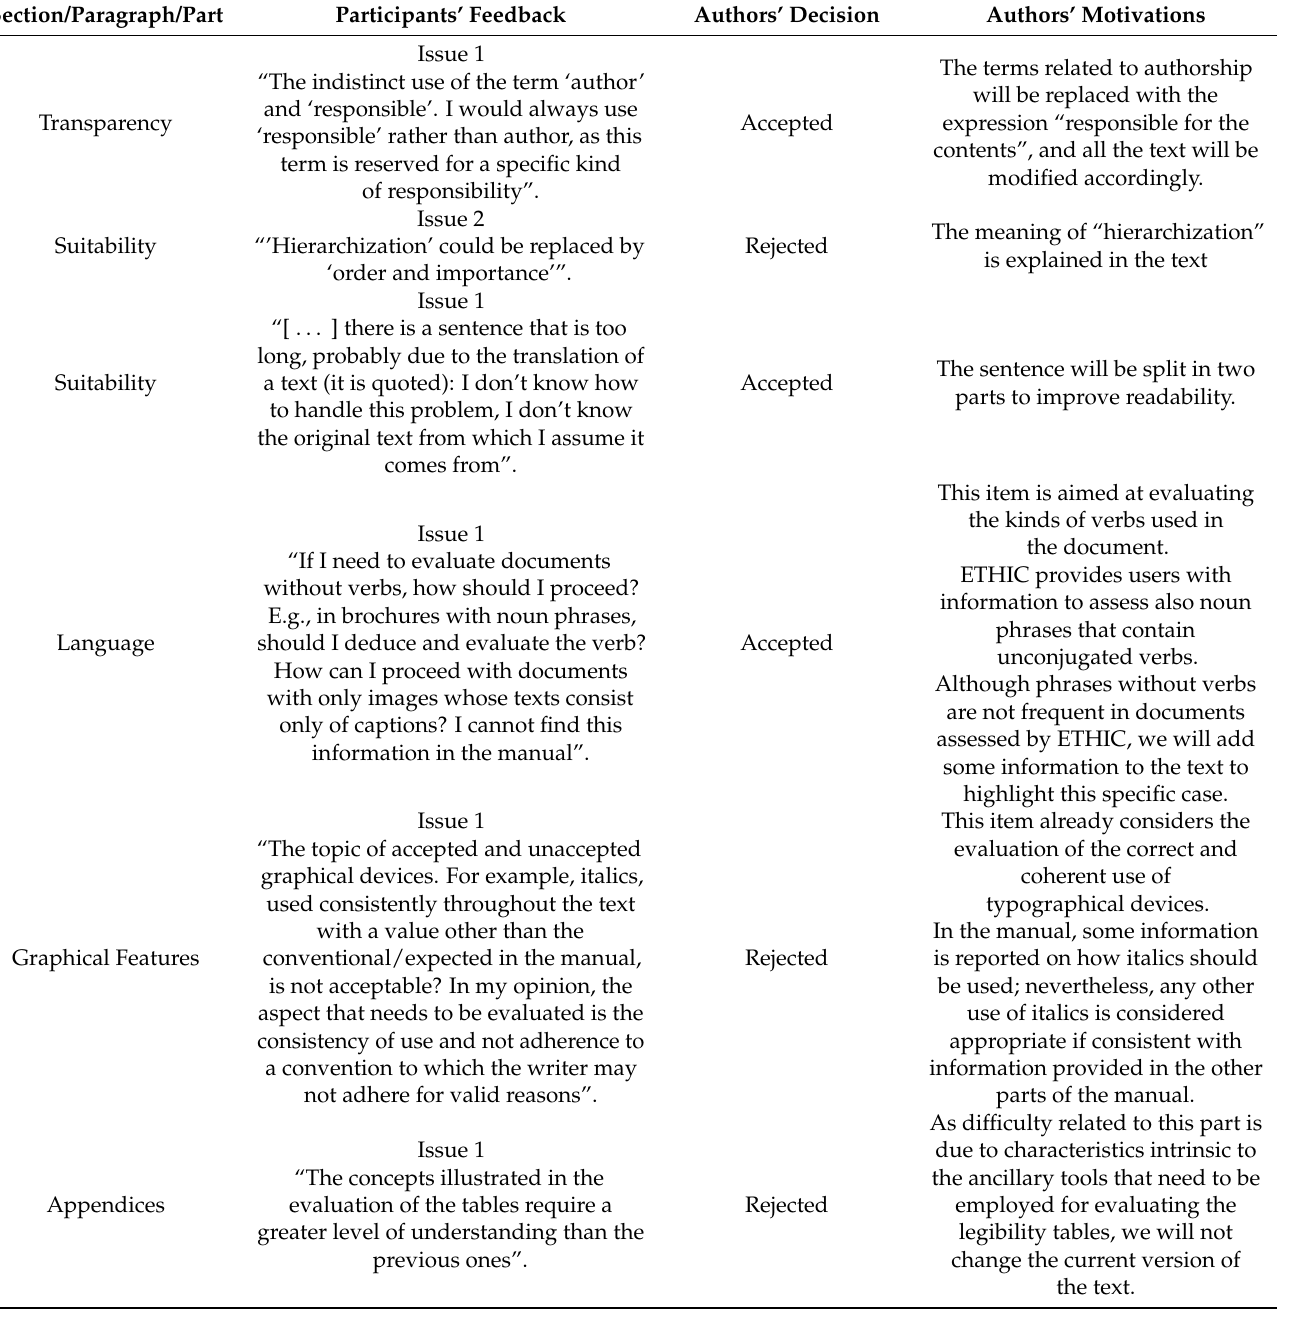
Table 2. Examples of participants’ feedback to issues 1 and 2 of the face validation form, and decisions made by the